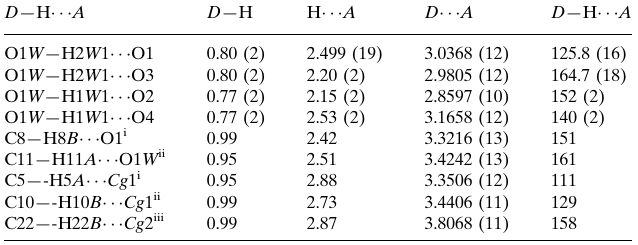
Hydrogen-bond geometry (A˚ , (cid:2)